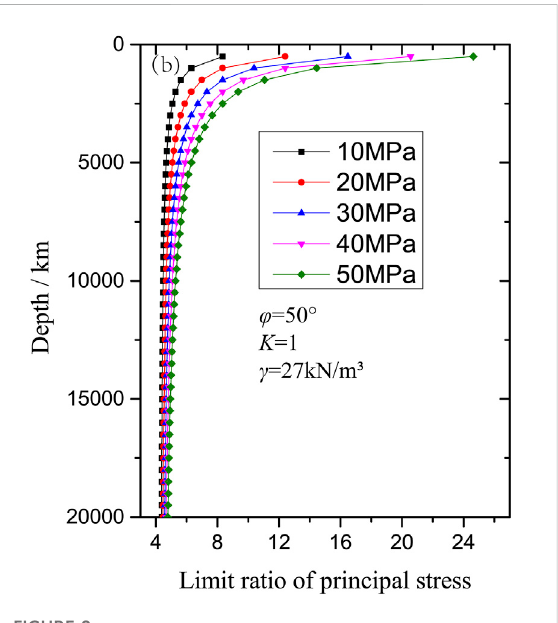
FIGURE 8 Distribution of stress limit ratio under different